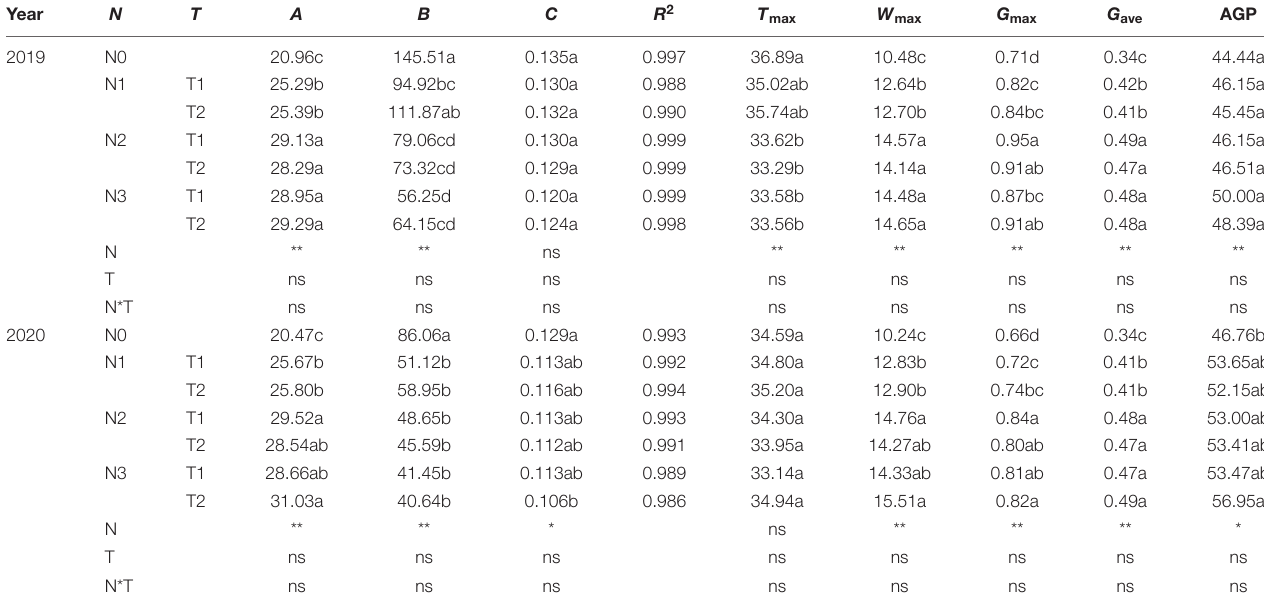
TABLE 3 | Effects of N rate and time on grain filling characteristics parameters of maize